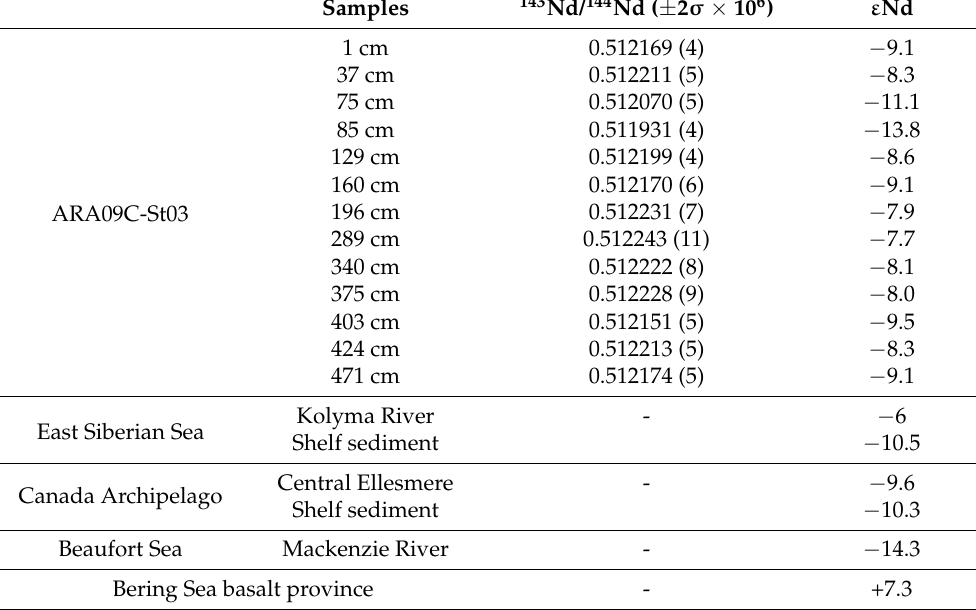
Table 3. Nd isotope data of core ARA09C-St03 and potential provenances from Fegel et al. [25].